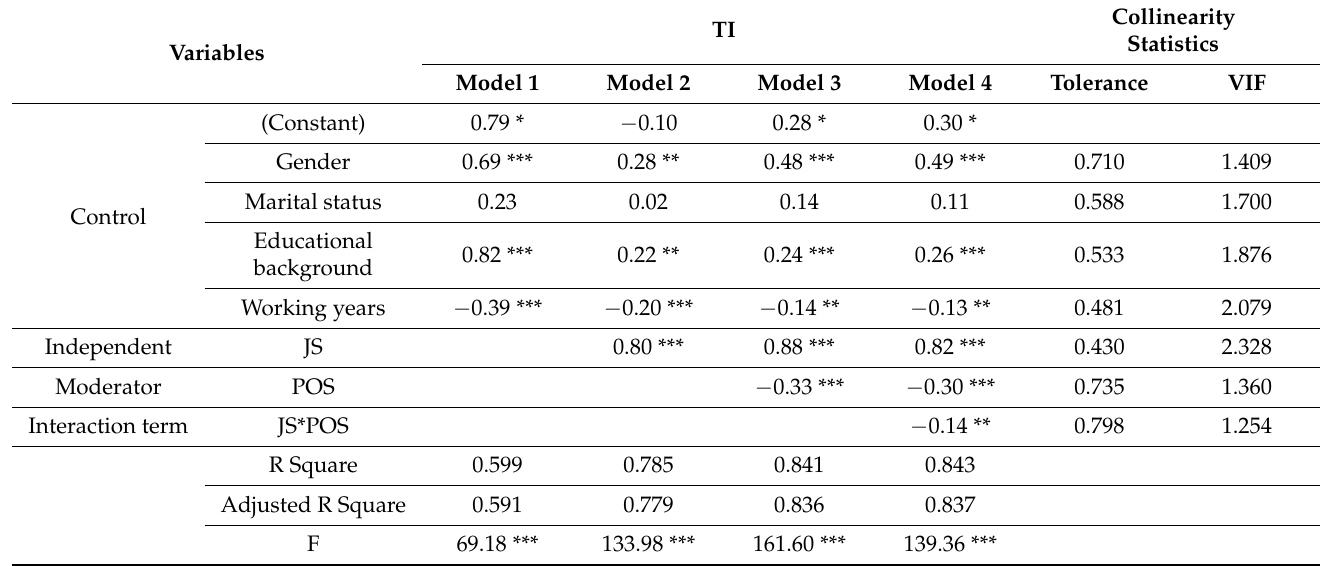
Table 8. The multiple regression